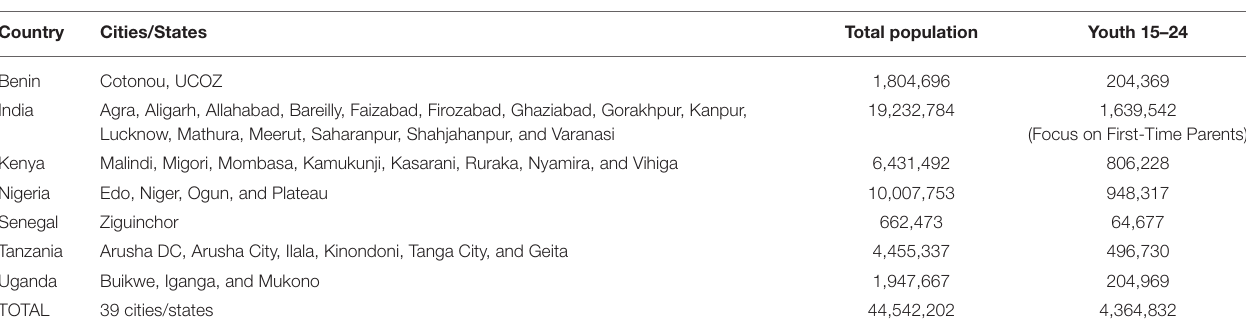
TABLE 1 | TCI geographic and population coverage.